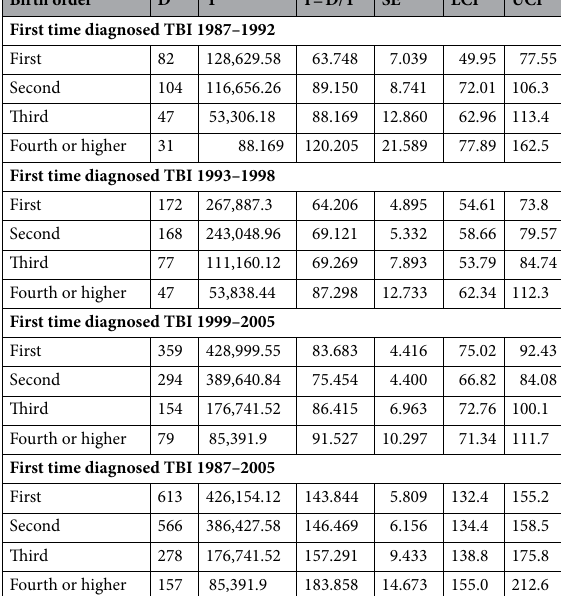
Table 5. Incidence of TBI across birth order categories, 1987–2005. I = incidence, D = TBI cases, Y = person- years = time from birth until TBI, death, emigration or end of the follow-up, LCI = lower bound of confidence interval(95%CI), UCI = upper bound of confidence interval